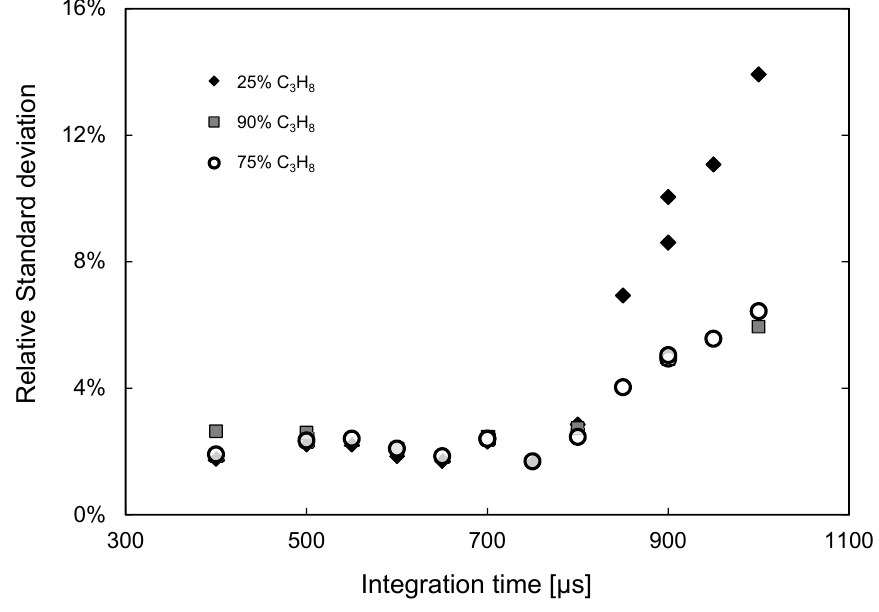
Figure 6. Influence of the camera integration time on the quality of the measurements in relative standard deviation of the measured intensities in the entire image for different C 3 H 8 concentrations.